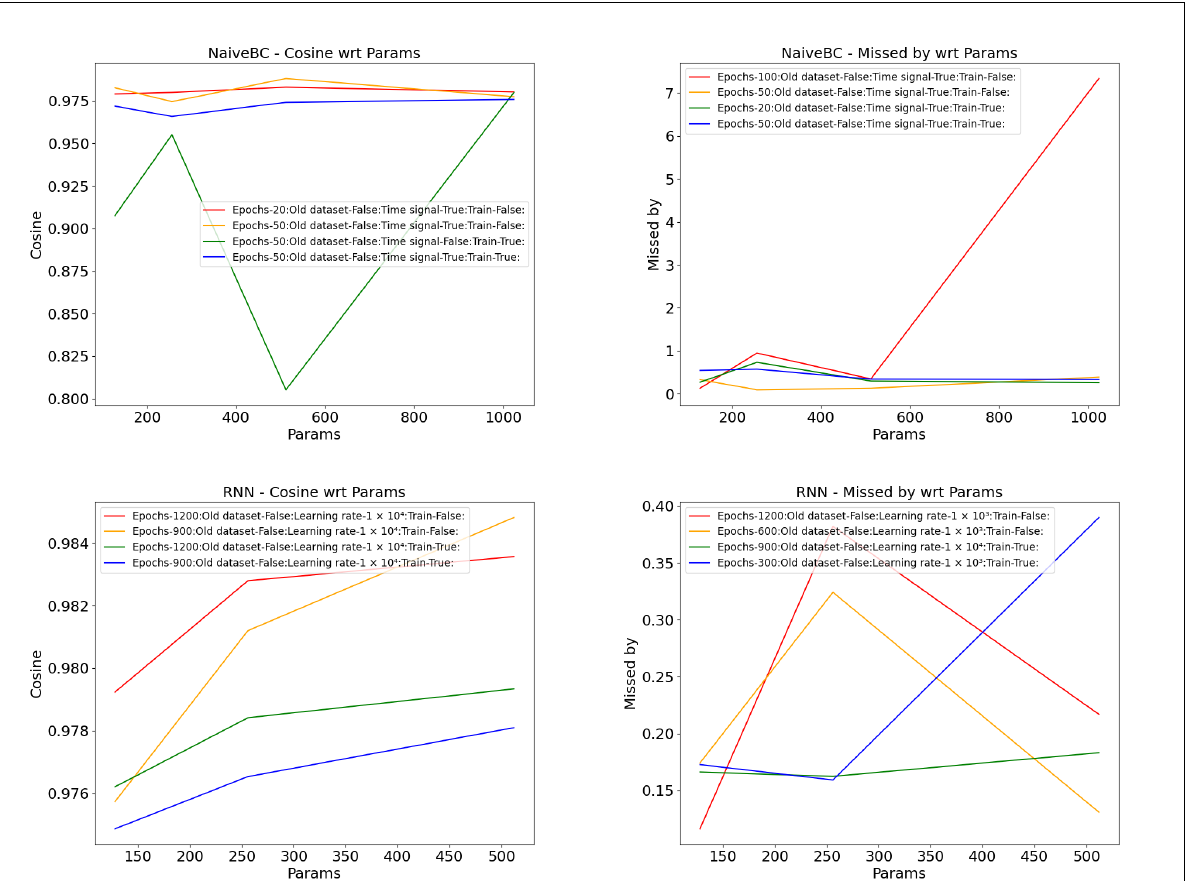
Figure 8. Results—cosine similarity (dimensionless) and mean throw error (meters) metrics for feedforward and recurrent models, only varying in the perceptron count parameter (others held constant)—best 2 on train and validation sets